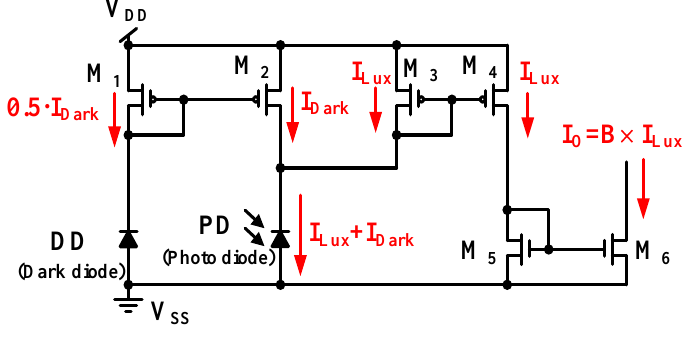
Figure 6. CA with dark current cancellation.